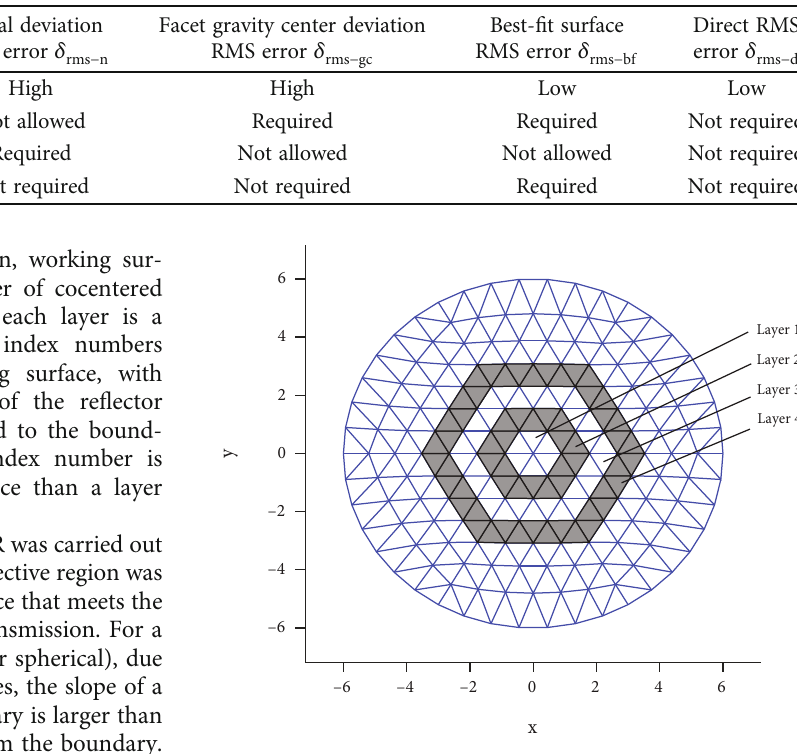
Table 1: Comparison of RMS error calculation methods for surface accuracy evaluation of a mesh geometry.